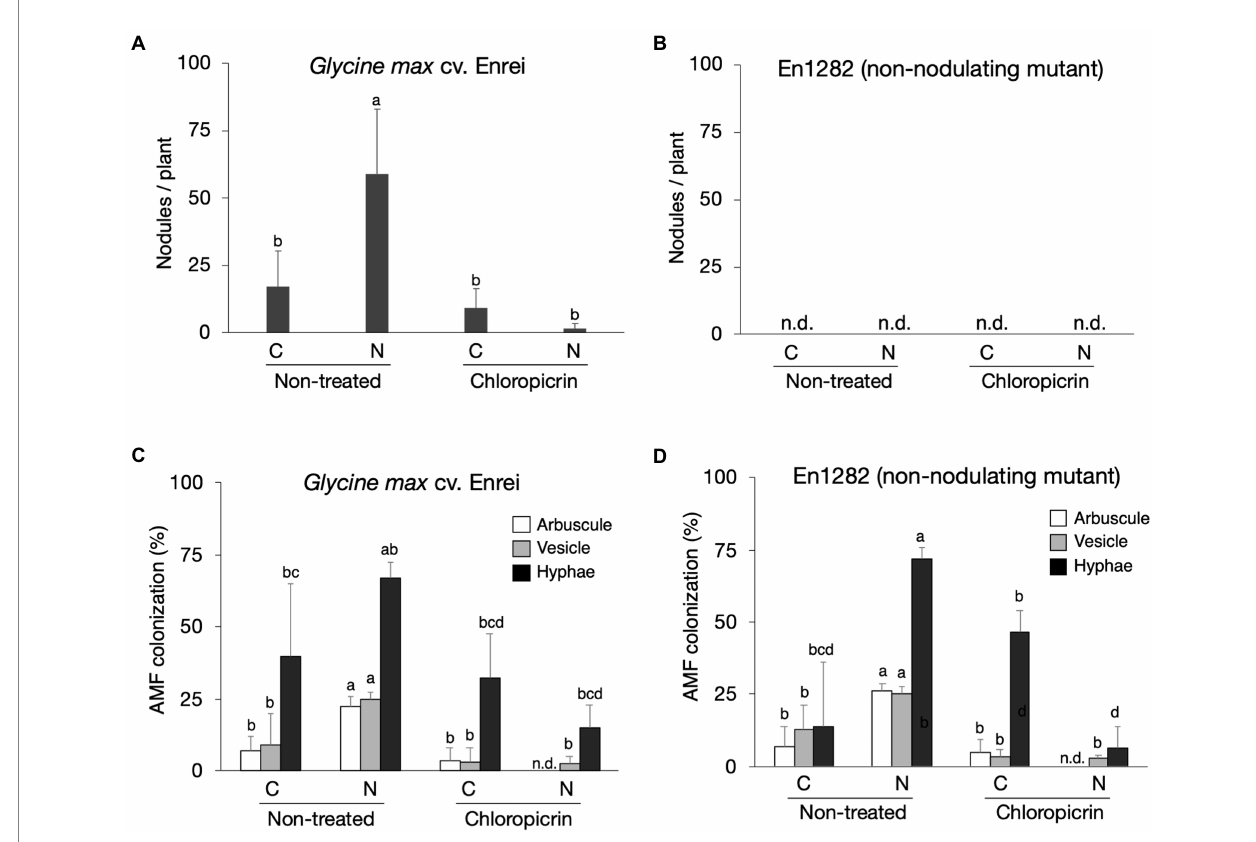
FIGURE 1 The effect of soils, fumigation, and soybean genotypes on average number of nodules (A,B) and the rate of AMF colonization in soybean roots based on the presence of arbuscles, vesicles, and hyphae (C,D) . Different letters indicate significant differences between samples based on the SNK test ( p < 0.05). C, conventional farming soil, N, nature farming soil, n =